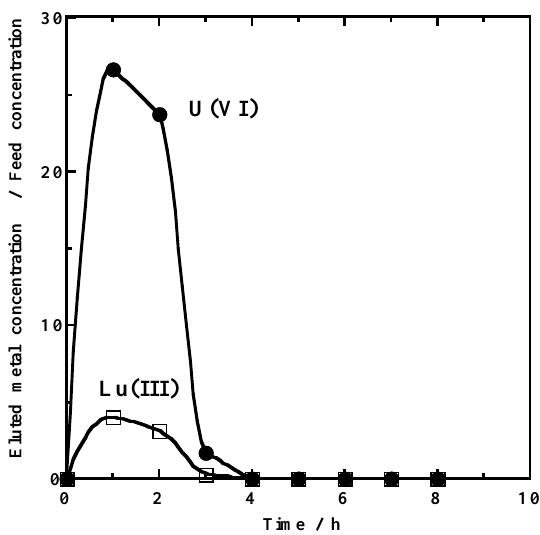
Figure 4. Elution profiles of uranium(VI) and lutetium(III) from the PP gel packed column after breakthrough using 1 mol·dm −3 hydrochloric acid